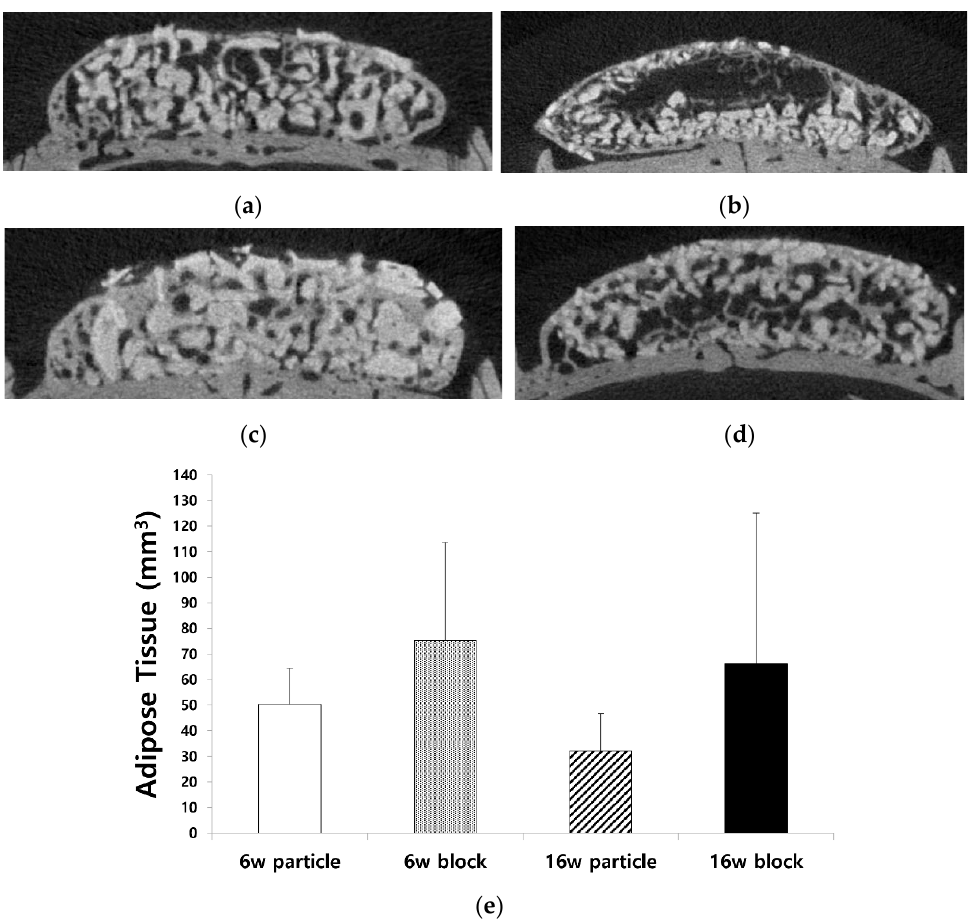
bone graft material in the particle group (Figure 4a,c), whereas it created a central vacant space inside the block bone graft material in the block group (Figure 4b,d). The particle groups exhibited lesser adipose tissue formation than the block groups at each time point. Figure 3. µ-CT images and volume of adipose tissue (ATV) in 6w particle, 6w block, 16w particle, and 16w block groups. ( a , b ) Void space formation in 6w and 16w particle groups, ( c , d ) vacant space in the central area of block bone graft material in 6w and 16w block groups. ( e ) There was no significant difference in the ATV among the four groups ( p = 0.264). mation in the 16w block group was markedly lesser than that in the 6w block group.